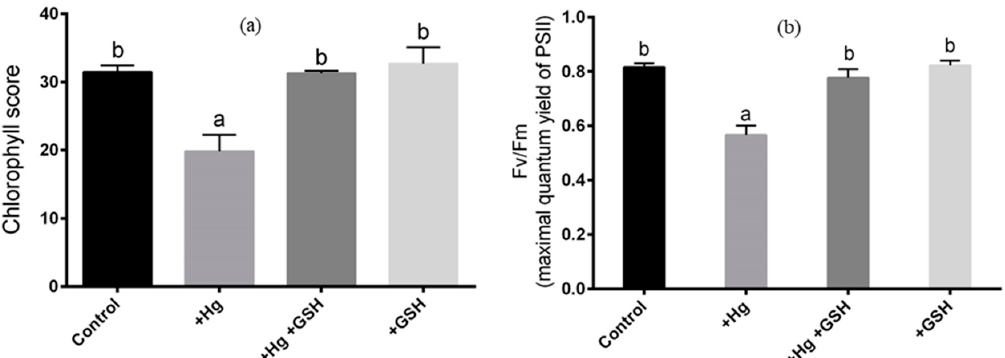
Figure 3. Changes in the chlorophyll score ( a ) and Fv/Fm ( b ) values in young leaves of alfalfa cultivated in different conditions of Hg and GSH: +Hg (40 μ M), +Hg+GSH (40 μ M Hg+50 μ M GSH), and +GSH (50 μ M GSH). Data represent means ± SD of three independent biological samples. Different letters indicate a significant difference at the p < 0.05 level.